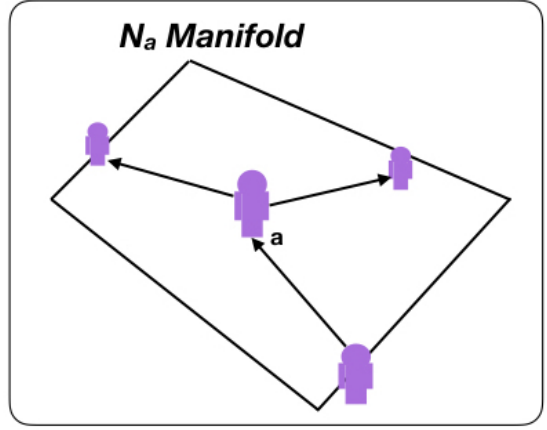
Figure 2. Local manifold upon which graph convolution acts.